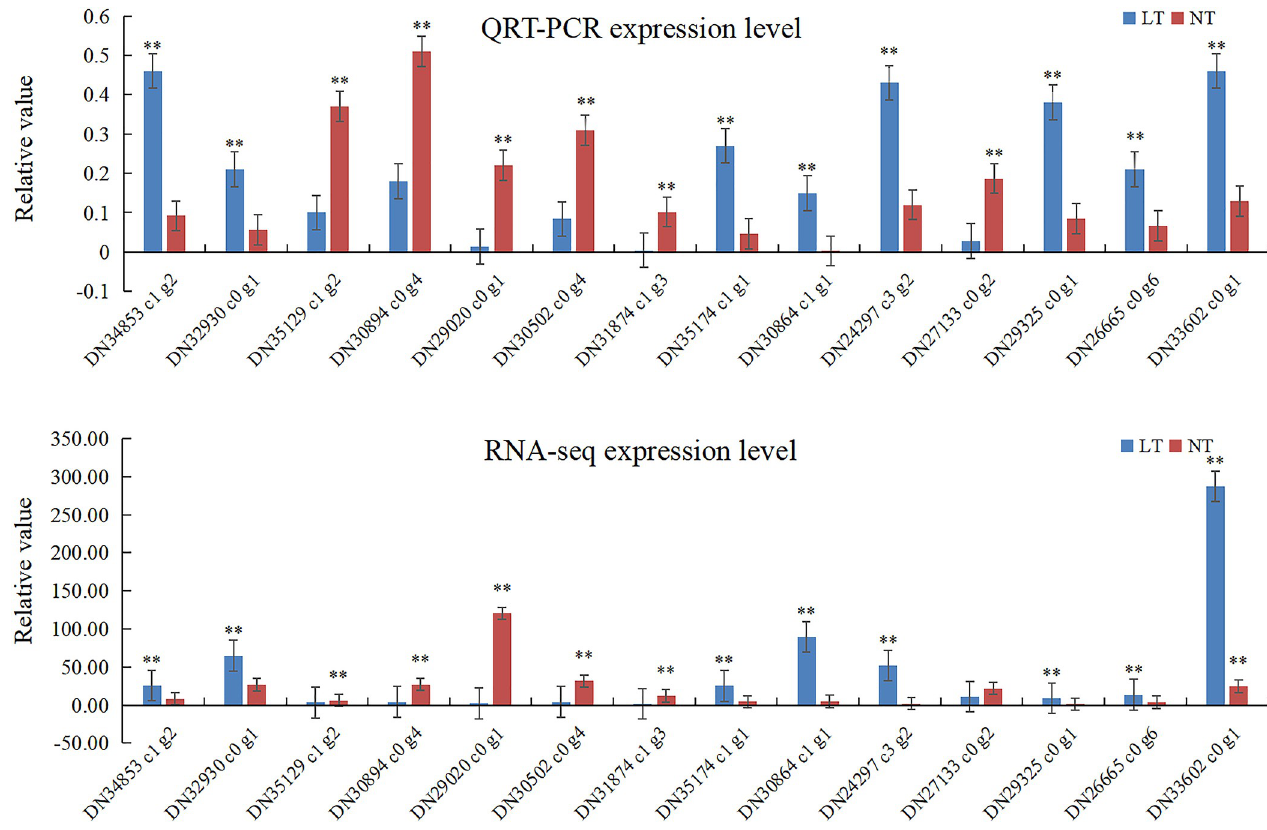
Fig 1. The 14 differentially expressed genes that were verified by qRT